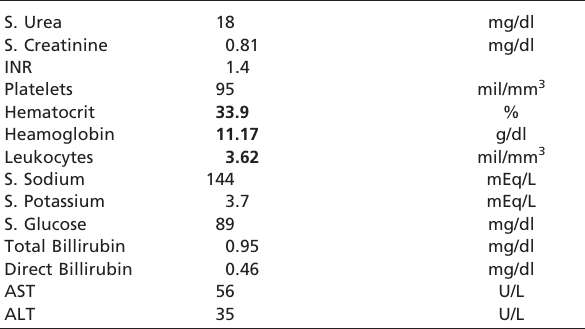
Table 1 - Postoperative laboratory